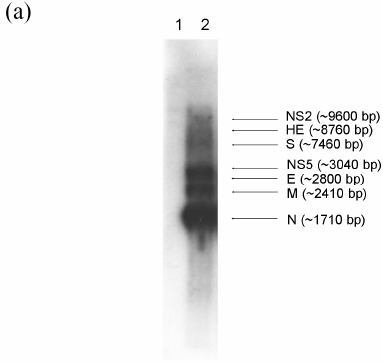
Figure 2. Cont. Figure 2. Cont.